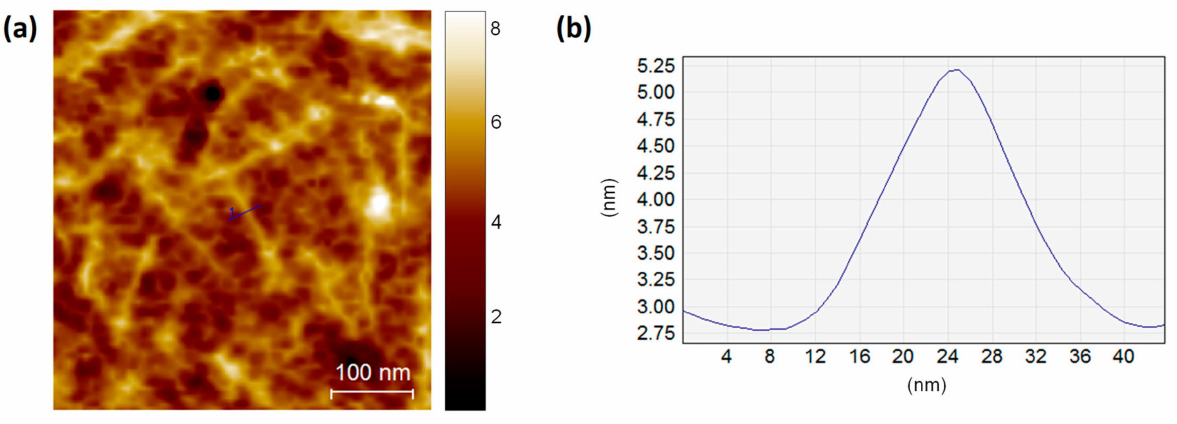
Figure 9. AFM height image (0.6 × 0.6 µ m 2 ) of AK1841052 ( a ) and height line profile ( b ) measured on the topography indicated by the blue line. AFM measurements were performed in tapping mode on dry